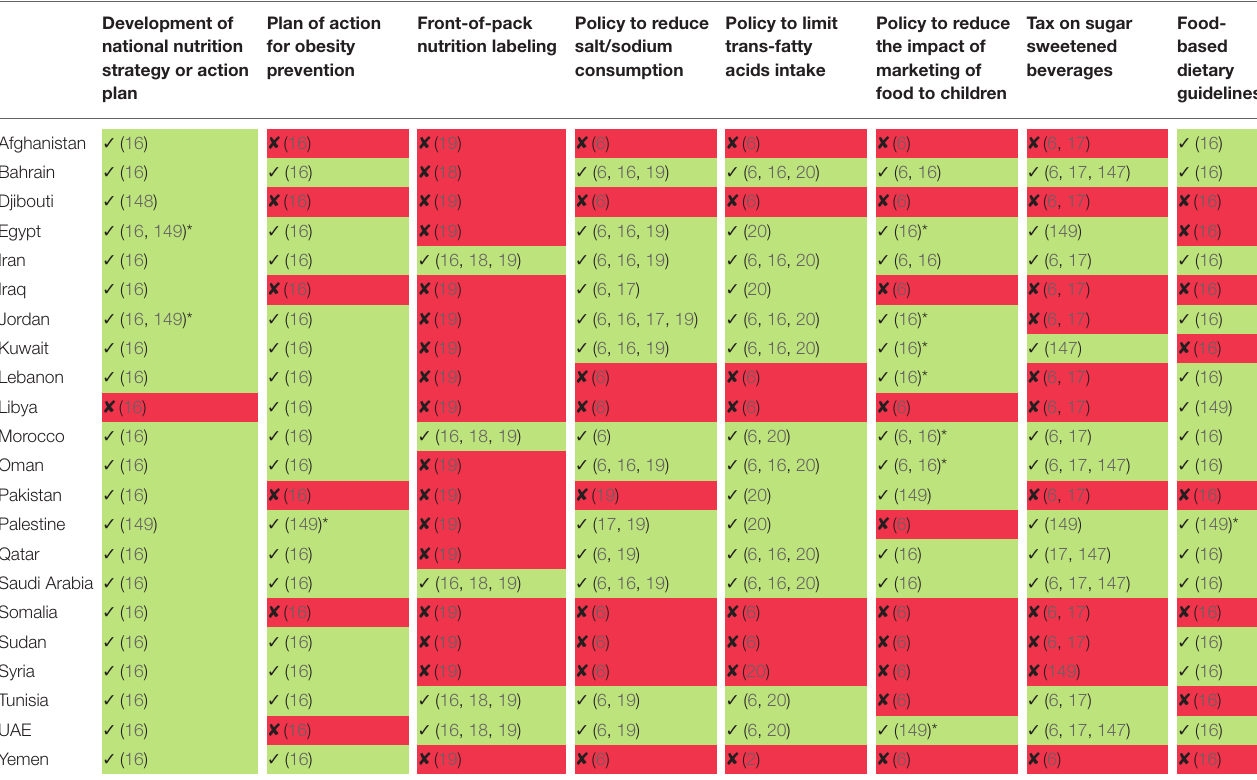
TABLE 6 | The polices available and implemented in EMR